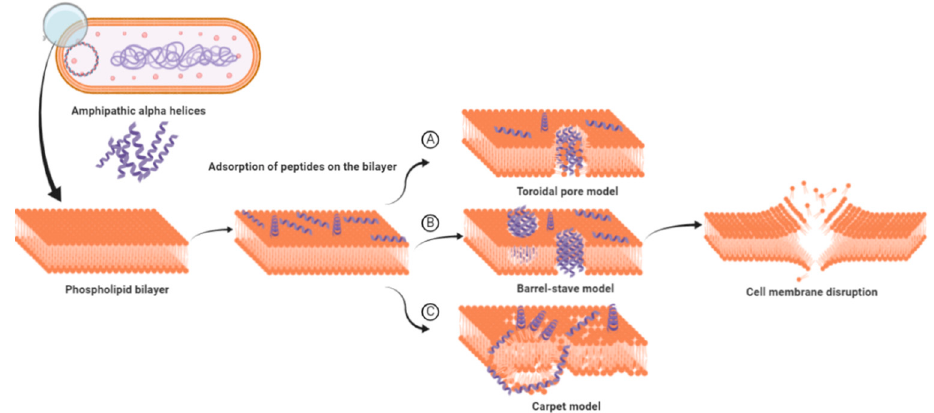
Figure 1. Models proposed for cell membrane disruption by amphipathic α -helix antimicrobial peptides (AMPs). ( A ) The toroidal pore model: hydrophilic region of AMPs are consistently in contact with the polar head groups of the phospholipid bilayer, causing the membrane to curve inward. ( B ) The barrel-stave model: hydrophobic region of AMPs interact with the lipid core of phospholipid bilayer, while the hydrophilic region points inward forming a channel-like structure. ( C ) The carpet model: above critical threshold concentration, AMPs distort the lipid bilayer structure resulting in the micellization of the structure (adapted from reference [36] and [37]).